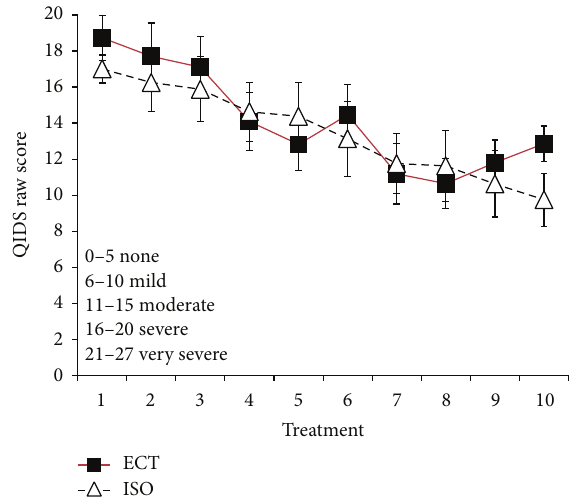
Figure 1: ECT and ISO display progressive improvements on quick inventory of depression scale (QIDS) self-report taken prior to each treatment.ECTpatientsareinsolidsquaresandISOpatientsinopen triangles. Both treatment groups display progressive improvement over the 10 treatments. As described in the demographics table, all ISO patients received 10 treatments and completed their QIDS-SR prior to each treatment. Conversely, 11/14 ECT patients completed their QIDS. For data at treatments 9 and 10, there were 10 and 7 patients, respectively, in the ECT group. The slight upturn at treatments 9 and 10 in the ECT group is the result of the more severely depressed patients requiring those final